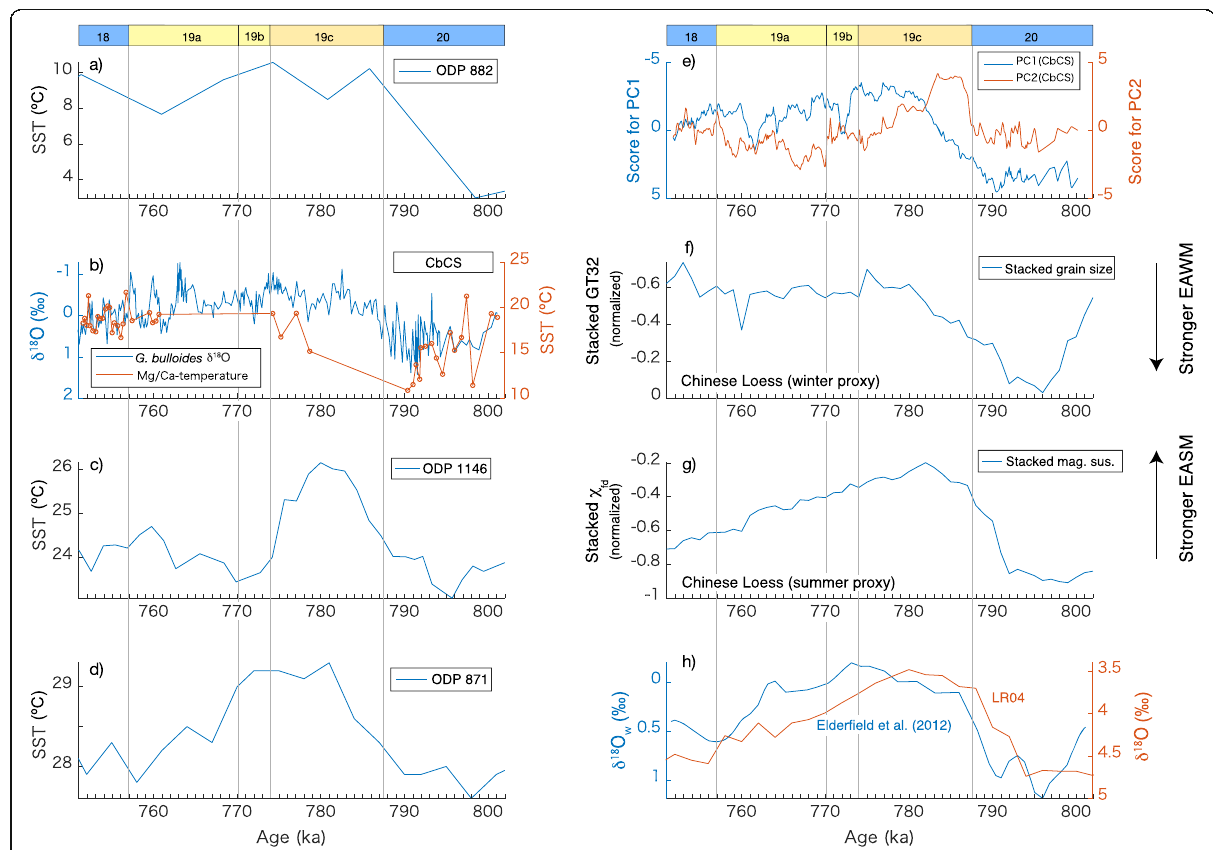
Fig. 5 Western Pacific sea-surface temperature (SST) records for a subarctic ODP Site 882 based on alkenones (Martínez-García et al. 2010), b the Chiba Composite Section (CbCS) based on G . bulloides δ 18 O (Suganuma et al. 2018; Haneda et al. 2020a) and Mg/Ca-based temperature (this study), c ODP Site 1146 in the South China Sea based on alkenones (Herbert et al. 2010), and d tropical ODP Site 871 based on Mg/Ca (Dyez and Ravelo 2014); in comparison with e principal component scores for the CbCS, f , g proxies from the Yimaguan and Luochuan sections of the Chinese Loess Plateau showing f stacked grain size and g stacked magnetic susceptibility records (Hao et al. 2012), h benthic δ 18 O w of Elderfield et al. (2012) (blue) and benthic δ 18 O stack of Lisiecki and Raymo (2005)